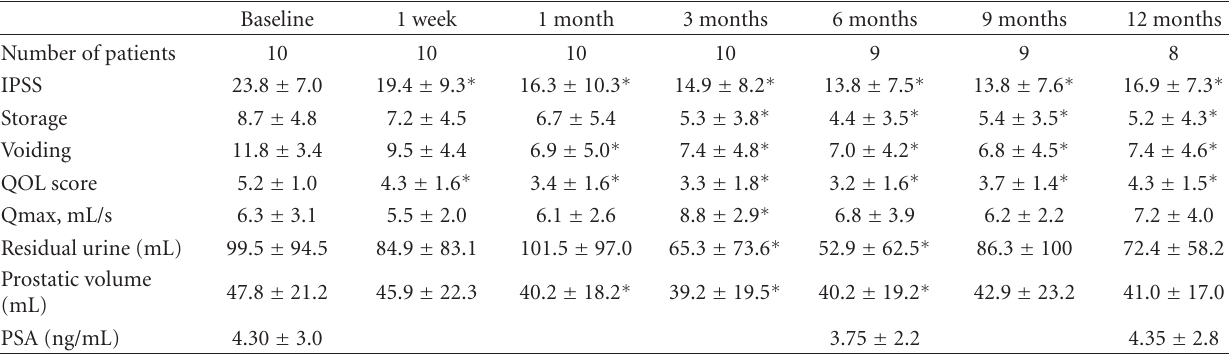
Table 2: BPH Patient profiles and results after intraprostatic NTX